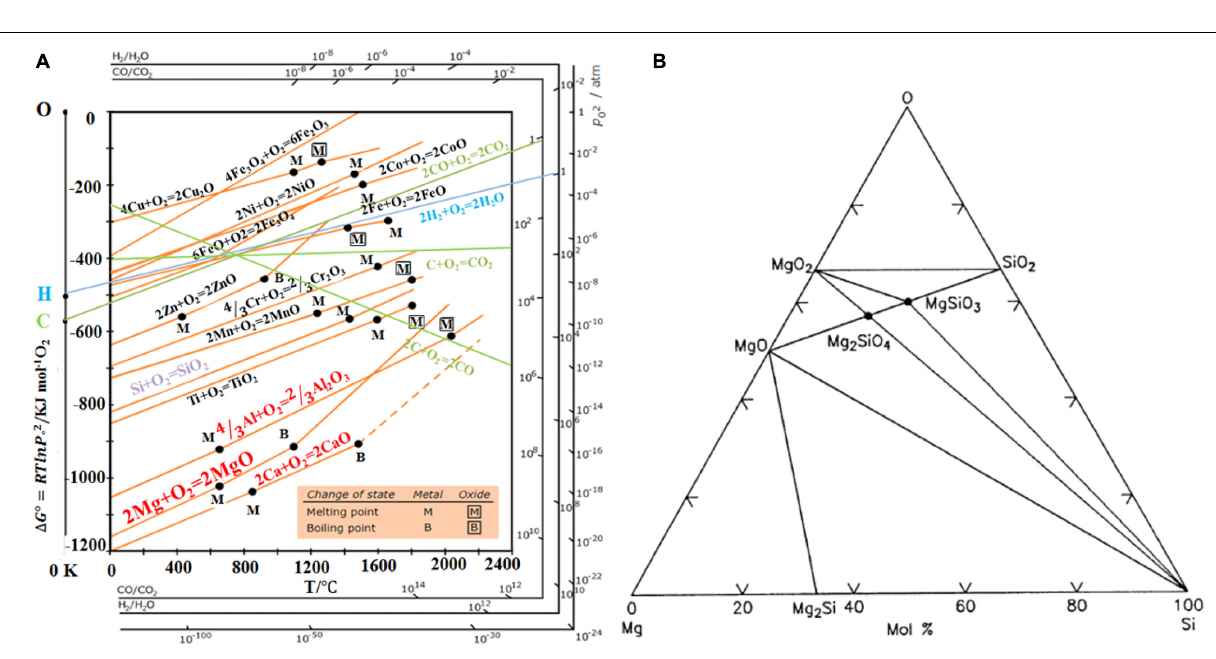
Frontiers in Energy Research |